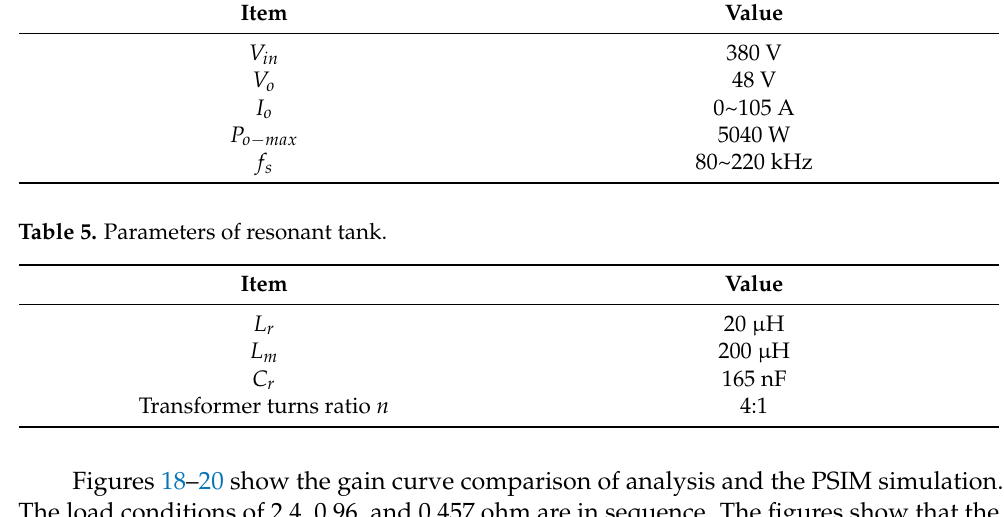
Table 4. Specification of three-phase wye–delta LLC.